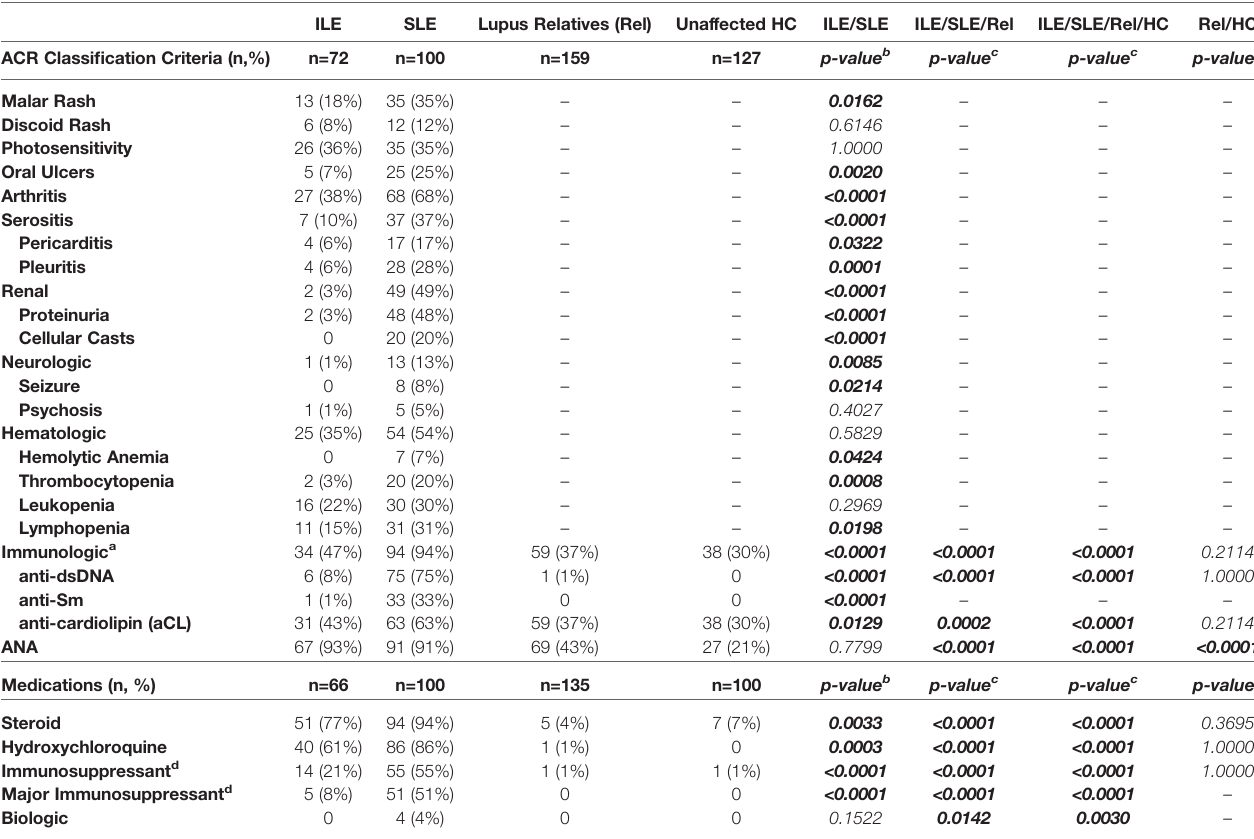
TABLE 5 | ACR Criteria and Medication in LFRR Con fi rmatory Nested Cohort (After SLE